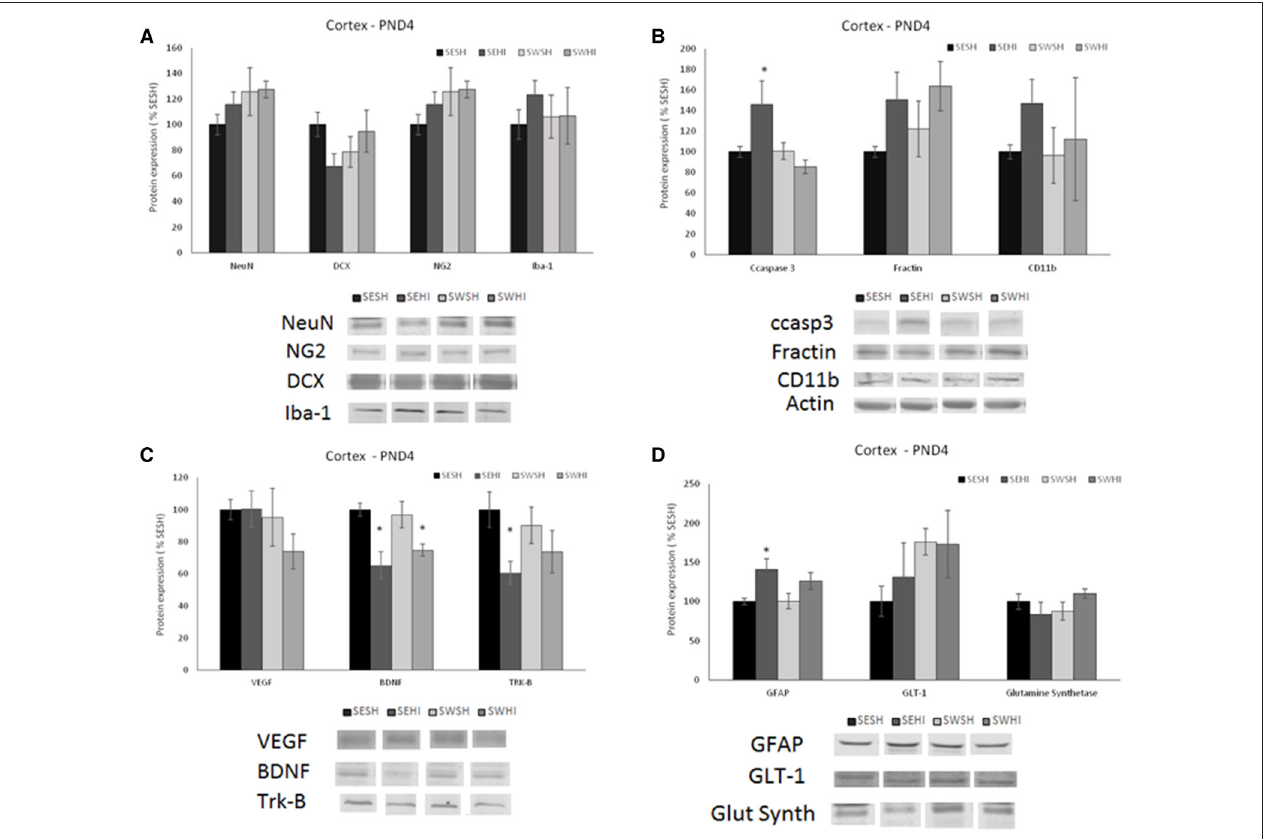
FIGURE 2 | Effect of pregnancy swimming on the pup’s protein levels in right cortex extracts 24h following HI (PND4). Bars graph represent immunoblots of (A) neurons (NeuN) and migrating neurons Doublecortin (DCX), oligodendrocytes progenitor (NG2) and microglia (Iba-1); (B) cell death (ccaspase 3 and fractin) and inflammation (CD11b), (C) neurotrophins VEGF and BDNF and the TRK-B receptor and (D) astrogliosis (GFAP), glutamate receptor GLT-1 and glutamine synthetase enzyme in the four experimental groups: sedentary sham (SESH), sedentary hypoxic-ischemic (SEHI), swimming sham (SWSH) and swimming hypoxic-ischemic (SWHI). WB results are plotted normalized to SESH level expression (100%) (mean ± SEM). Significance testing was determined using one-way ANOVA followed by Duncan’s post hoc and was performed on Actin or β III-tubulin normalized data. *HI vs. its respective SH group, Significance accepted when p <